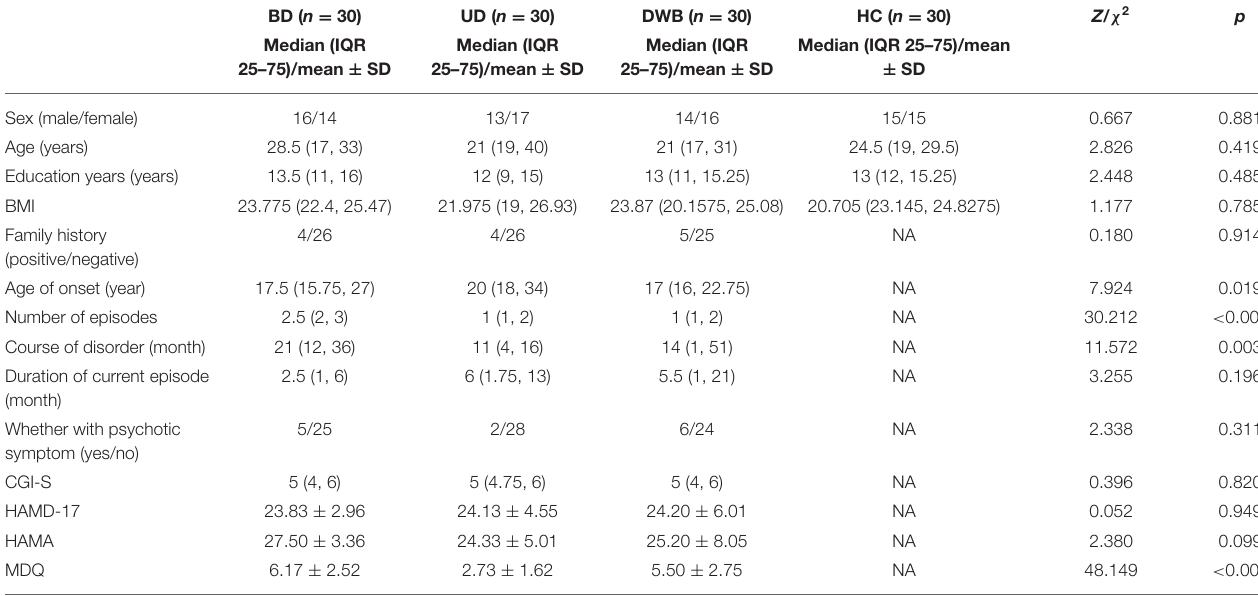
TABLE 1 | Demographic and clinical characteristics of participants.